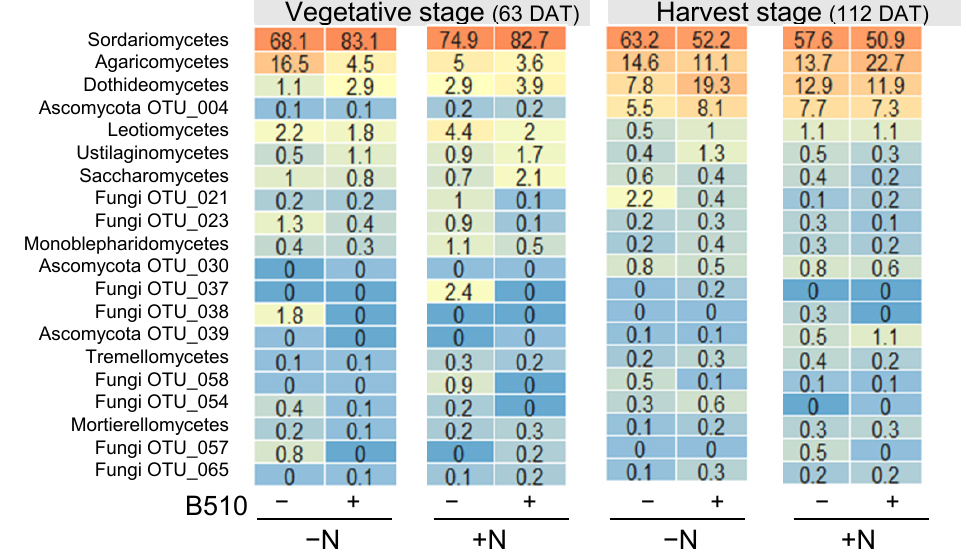
Figure 6. Heat Map of the top 20 fungal species associated with rice roots at the vegetative stage (63 DAT) and harvest stage (112 DAT). The heat-maps show the relative abundances of fungal operational taxonomic units (OTUs) at the class level from rice plants inoculated with B510 (+) and without B510 (-) and with supplemental nitrogen fertilizer (+N) and without N-fertilizer (-N). The color of the heat-map indicates the relative abundance from high (red) to low (blue). The asterisks identify